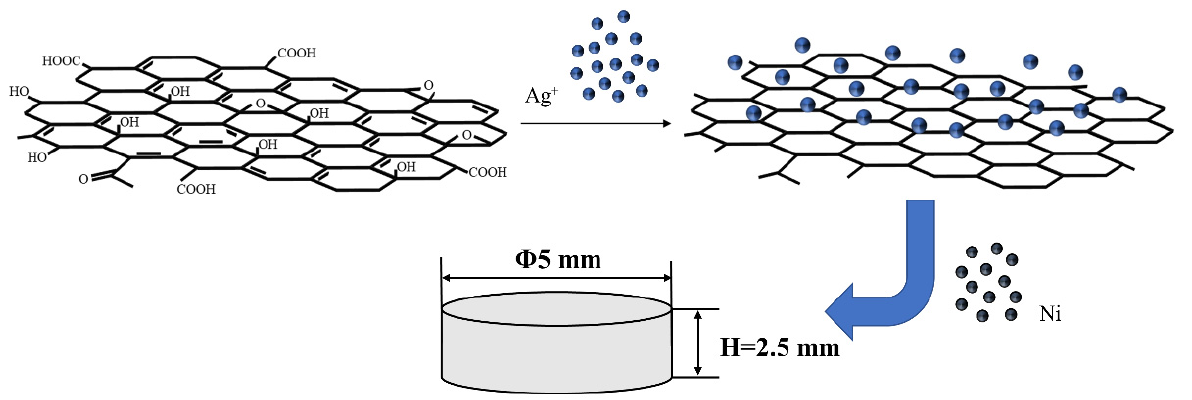
Figure 1. Schematic illustration of the synthesis of the Ag-graphene/Ni composite.